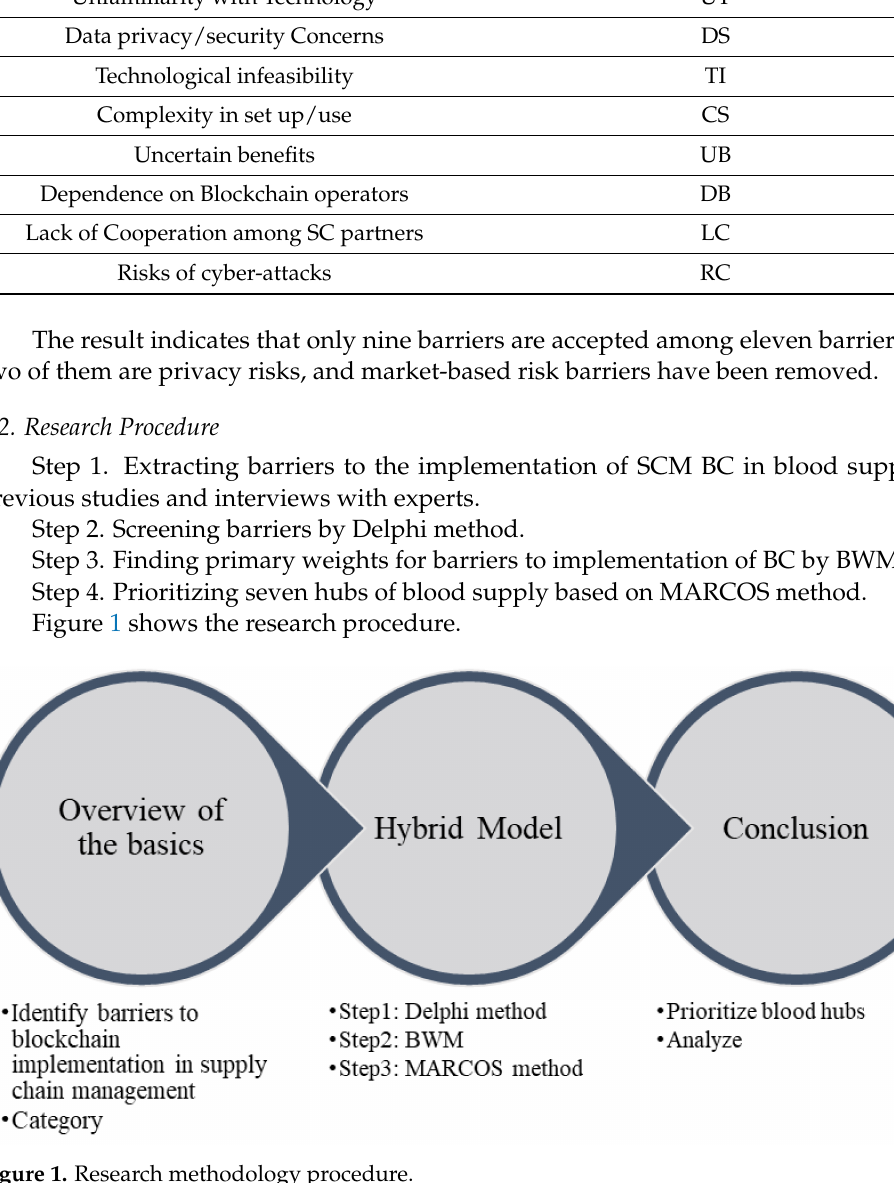
Figure 1. Research methodology